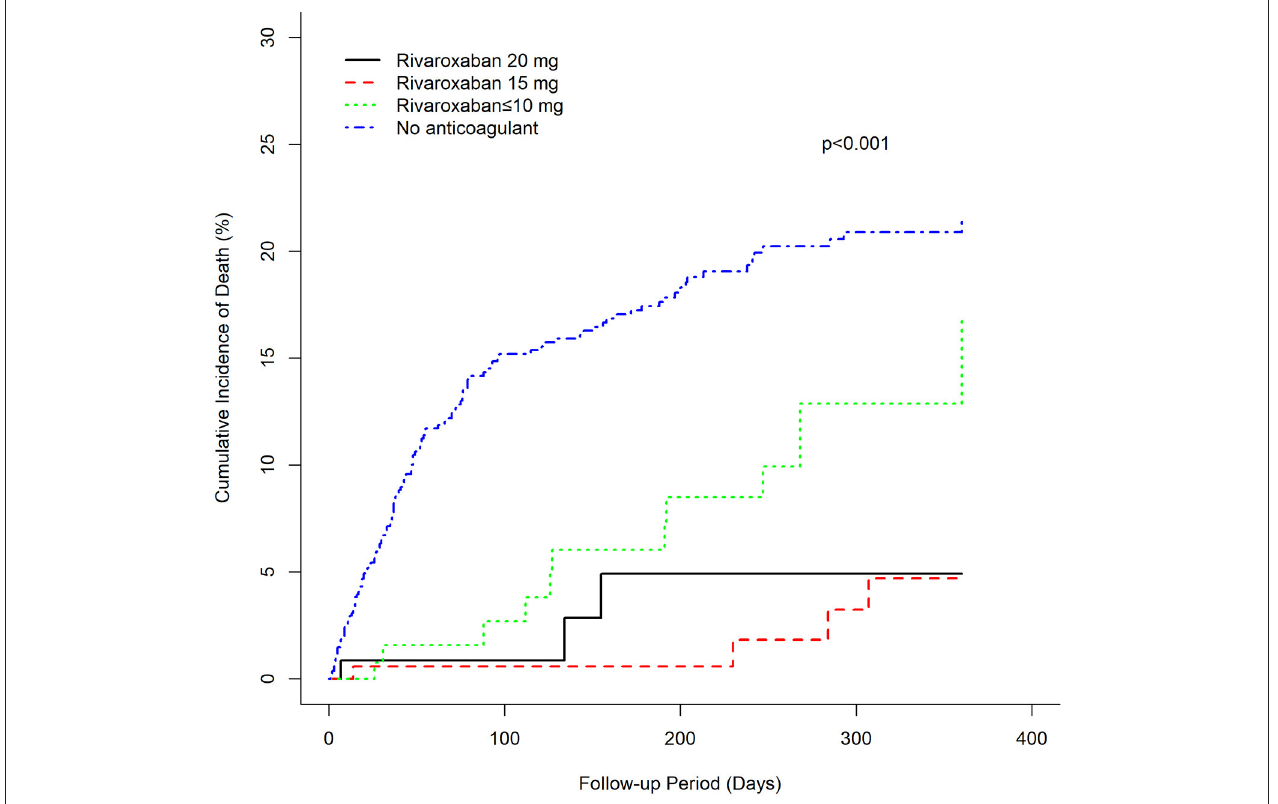
FIGURE 3 | Cumulative mortality of rivaroxaban groups and the anticoagulant-untreated group.